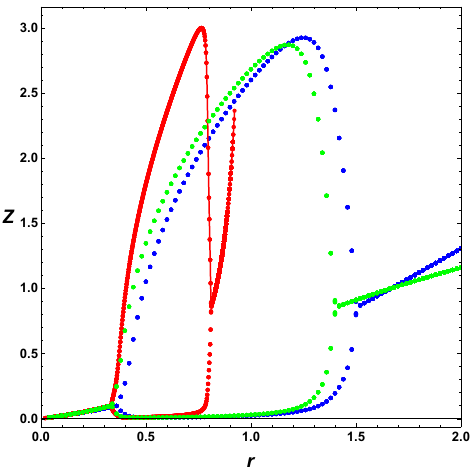
Figure 8. Poincare section of extrema, with k d = 1, k u = 0.01, K = 0.20 and φ = 1. Red implies constant input; blue implies m = 1; and green implies m = 2.